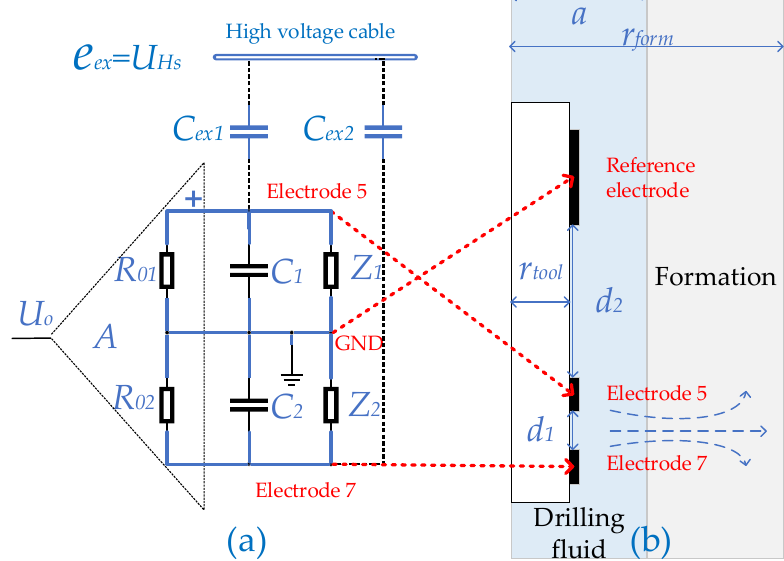
Figure 12. Electrically coupled model. ( a ) Signal model; ( b ) Formation model.